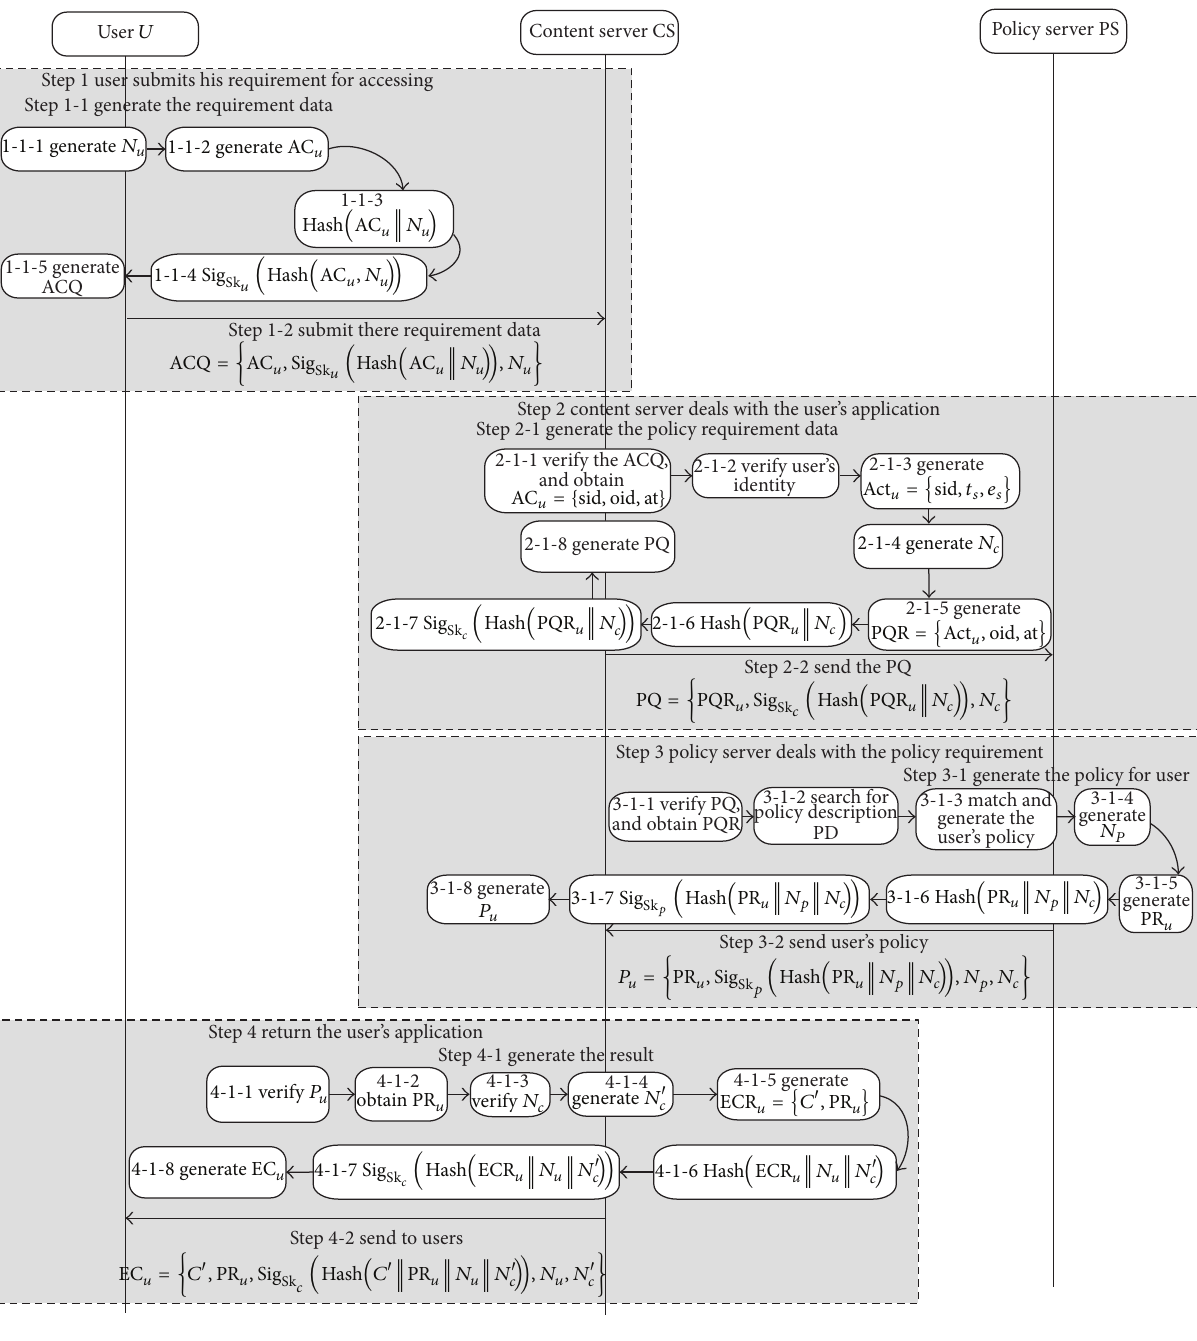
Figure 4: The process of users’